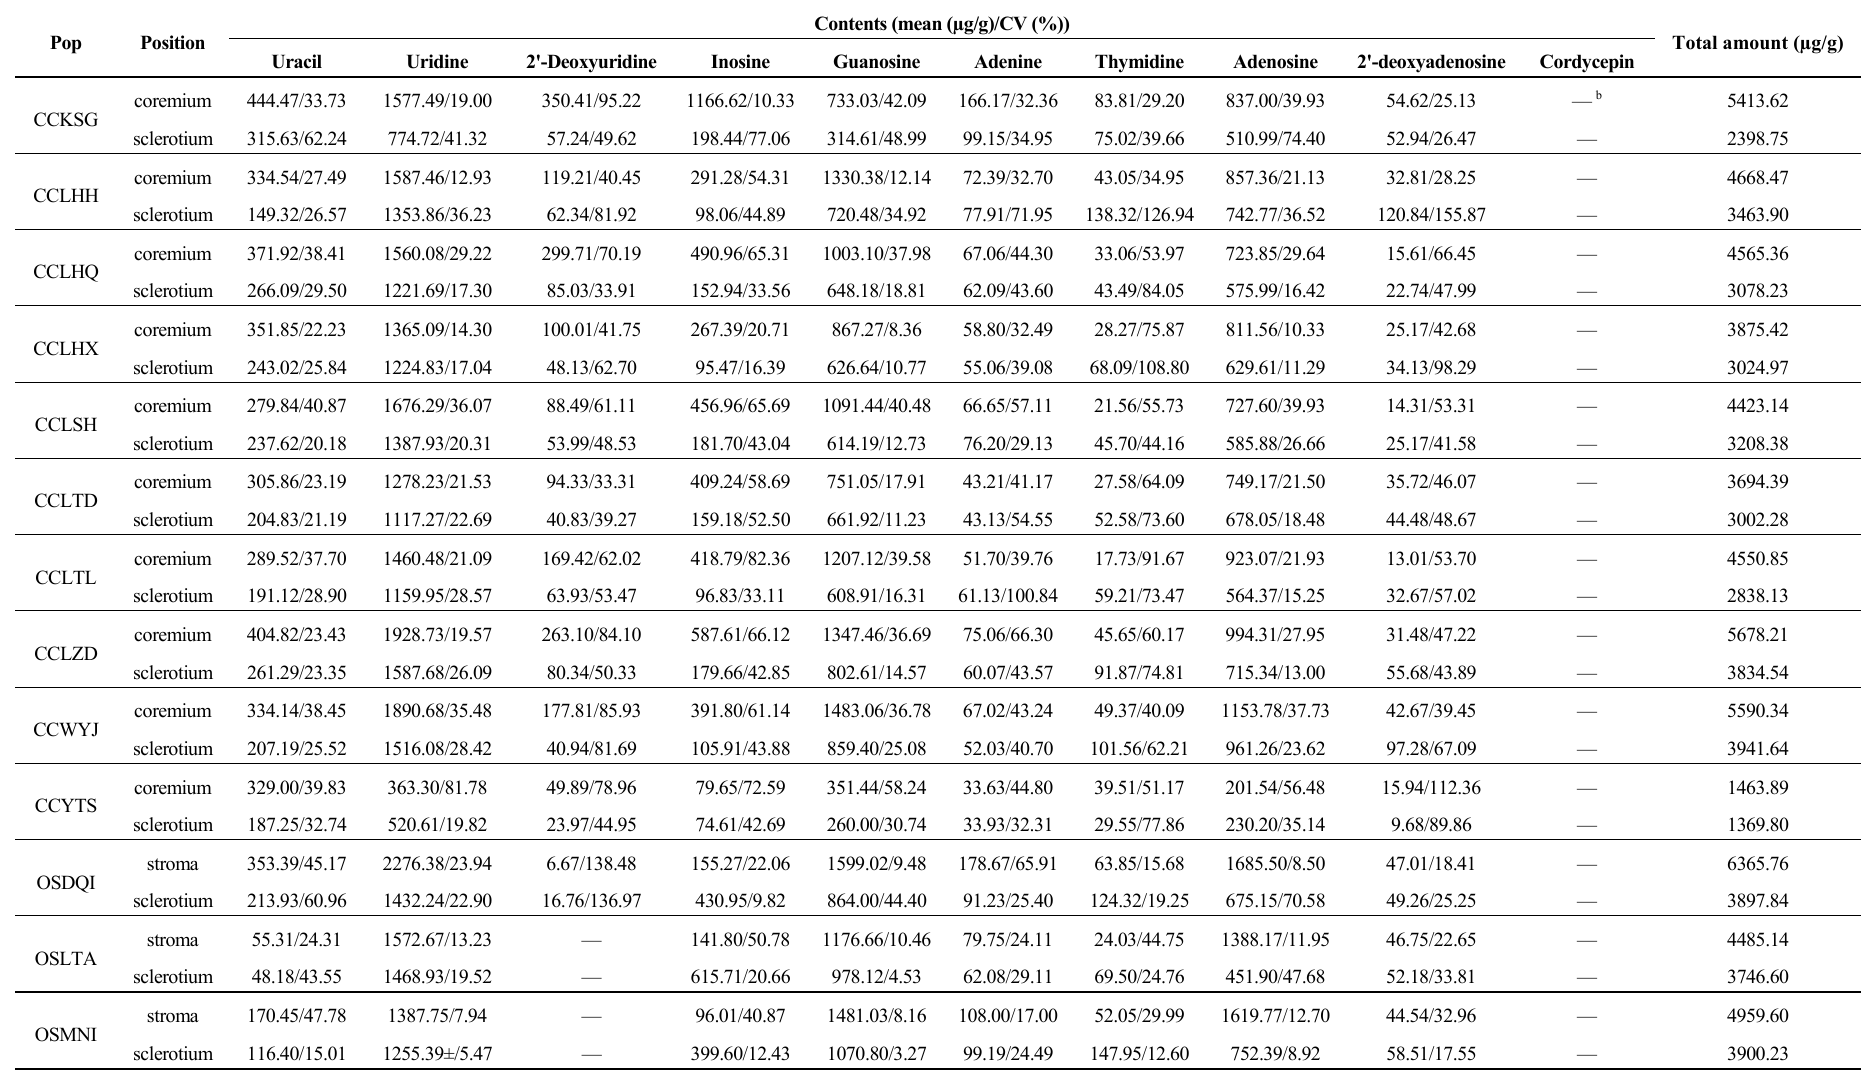
Table 2. The content of 10 nucleosides in 10 populations of C. cicadae , four populations of O. sinensis and one population of C. militairis